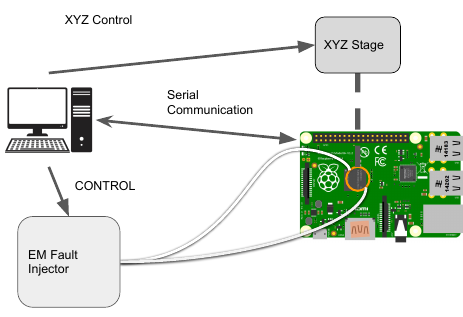
Figure 4. Cartography setup. A PC is connected to the XYZ stage’s arm to be able to move the magnetic coil across the surface of the chip, connected via serial interface to the DUT and connected to the EM fault injector to activate it.